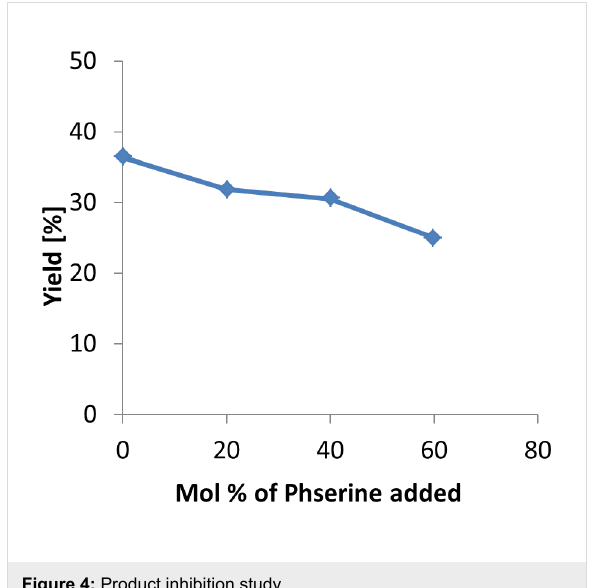
Figure 4: Product inhibition